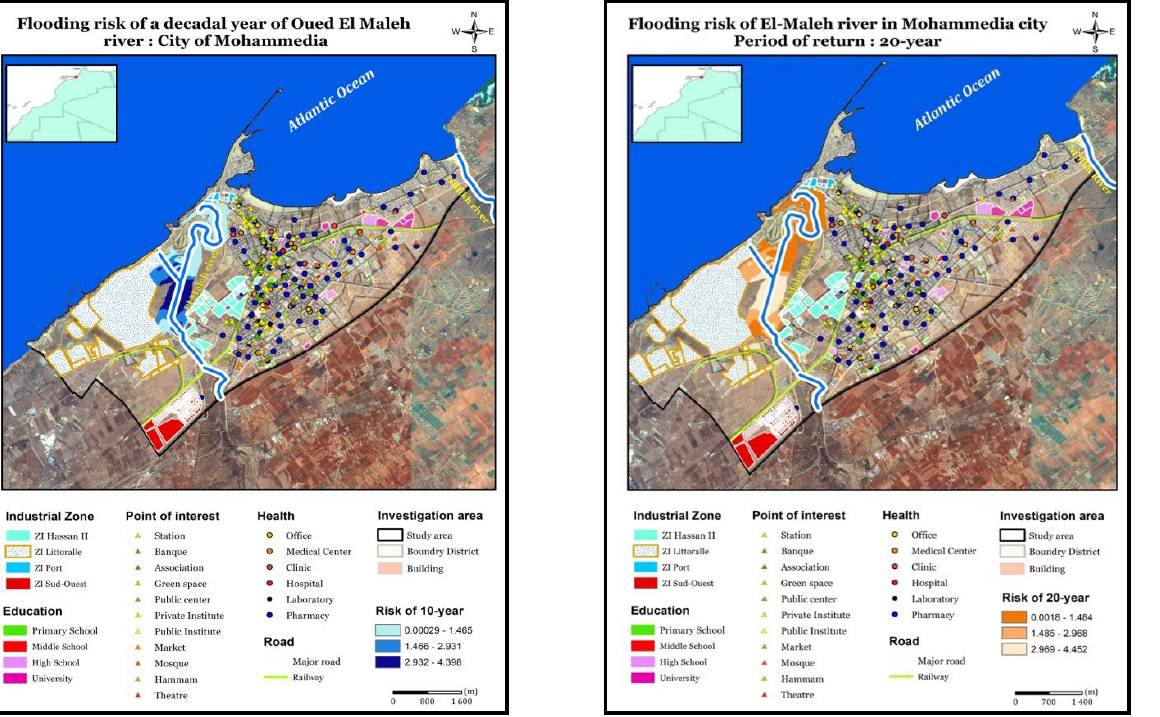
Figure 7. Flooding risk of a decadal year